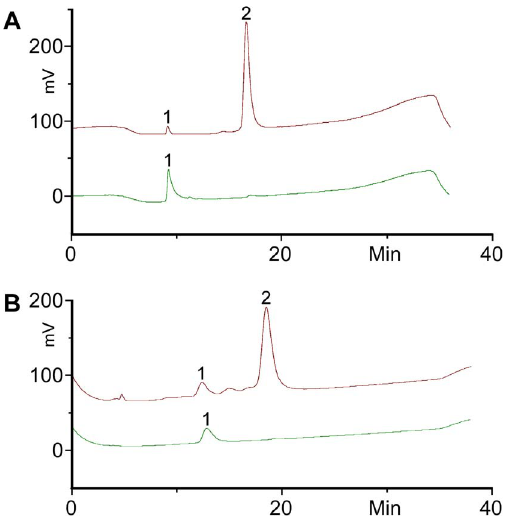
Figure 5. HPLC chromatograms of BODIPY-GM3 (A) and BODIPY-GD1a (B) recovered from enzyme reactions; reaction products from the sialyltransferase reactions were purified by HPLC and analysed (top trace) showing mainly the product (peak 2) and only little amounts of starting material (peak 1). The samples were treated with sialidase overnight at 37 u C (lower trace, approximately 10-fold dilution from treatment before) and analysed showing complete conversion to the starting material (peak 1).